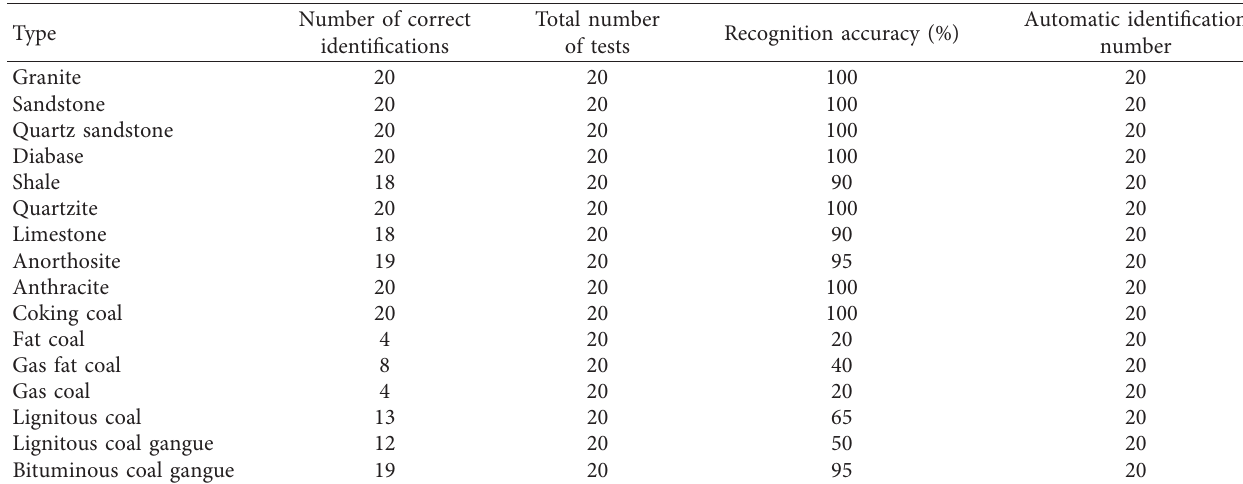
Figure 9: Anorthosite-coking coal image. (a) Image before processing. (b) Image after processing. (c) Identification results. Table 4: Identification accuracy test.